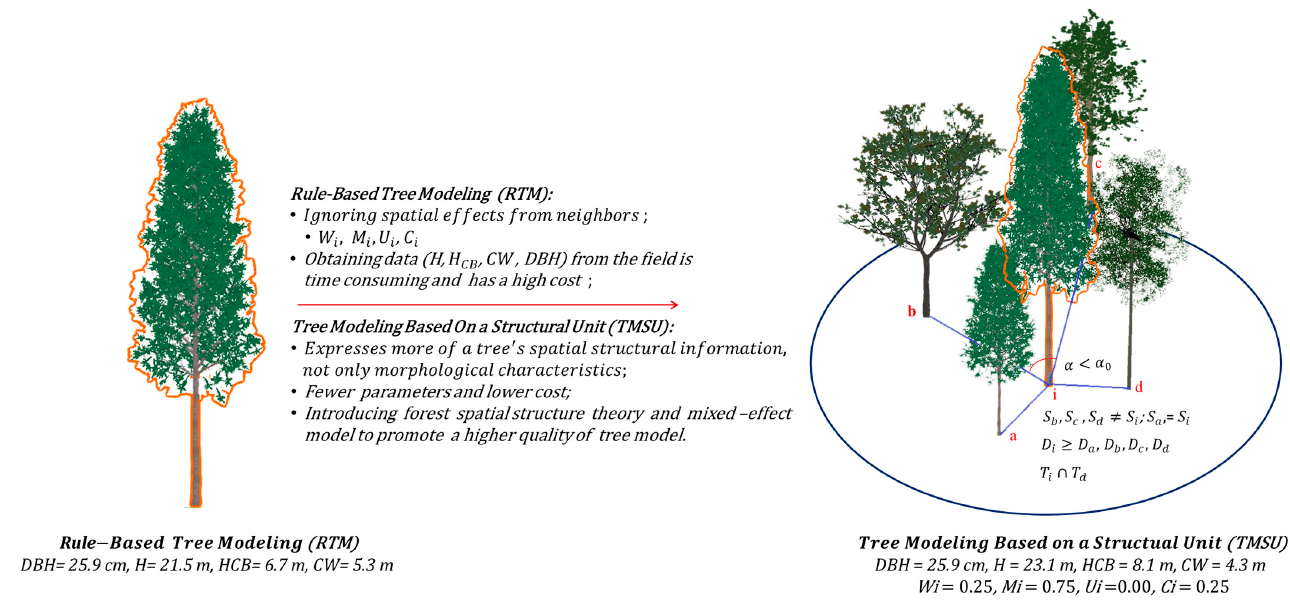
Figure 4. Three-dimensional tree modeling based on RTM and TMSU.